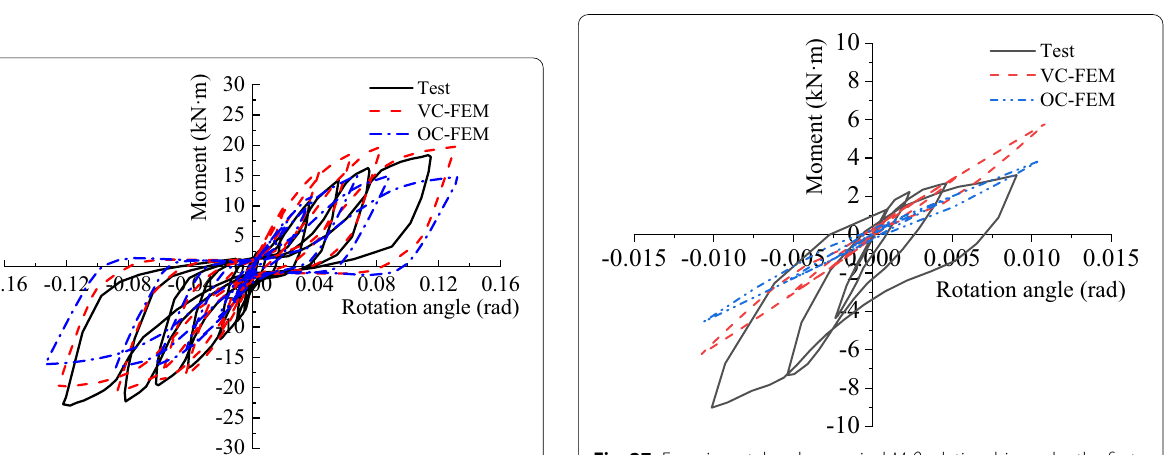
Fig. 27 Experimental and numerical M - θ relationship under the first four initial cycle